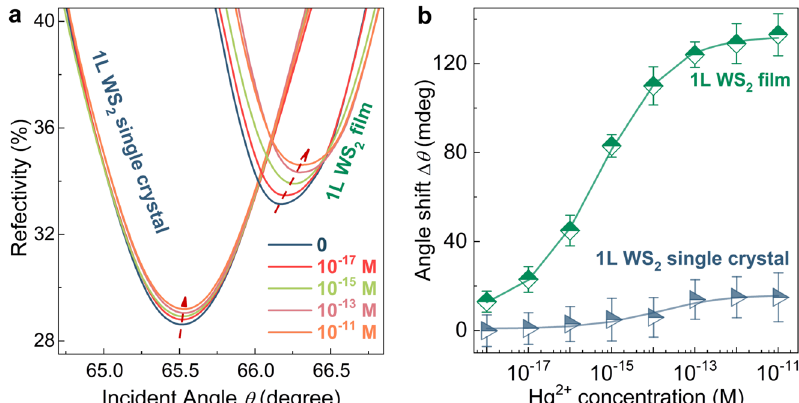
Fig. 2 Hg 2 + detection of SPR sensor based on GB-rich 1L WS 2 fi lm and 1L WS 2 single crystal. a SPR spectra at Hg 2 + concentrations ranging from 10 − 18 M to 10 − 11 M. b Corresponding extracted resonance angle shifts of Δ θ . For the prepared 10 − 18 M Hg 2 + concentration, the x -axis error bar was estimated to be ±0.1 × 10 − 18 M ( “ Methods ” ). At each Hg 2 + concentration, the collection of data was performed for 5 times, from which the average value of Δ θ and y-error bar were